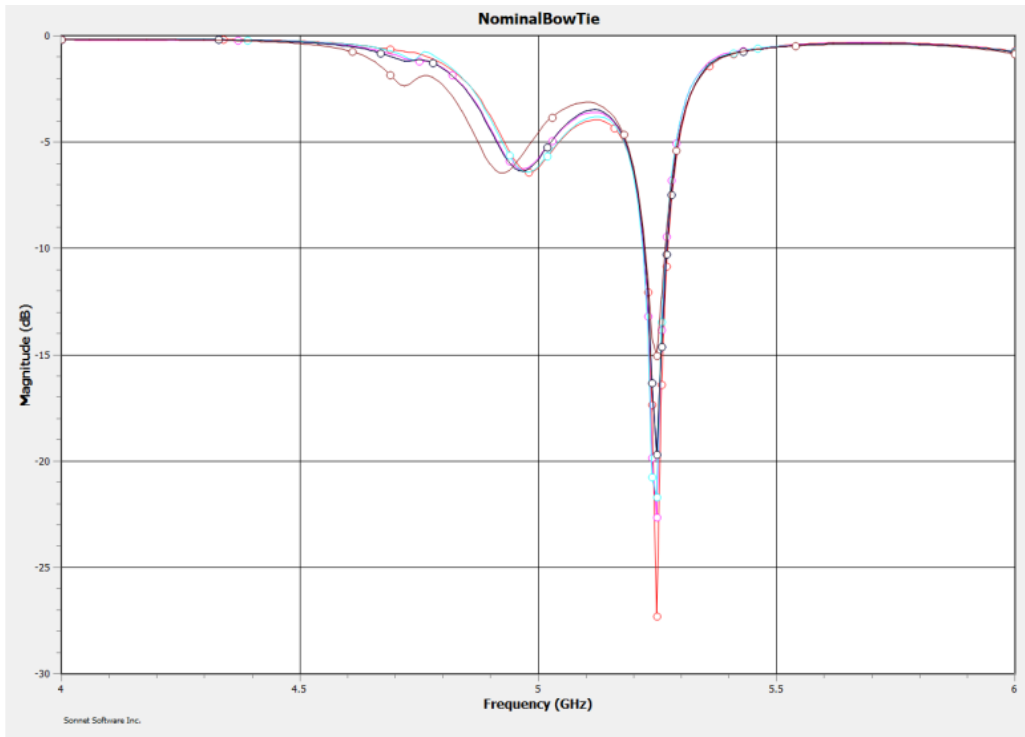
Figure 5. Magnitude/Frequency graph for all angle changes in point